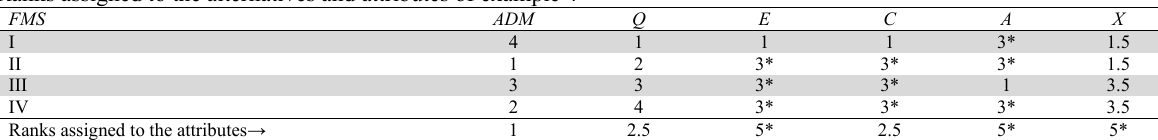
Ranks assigned to the alternatives and attributes of example 4